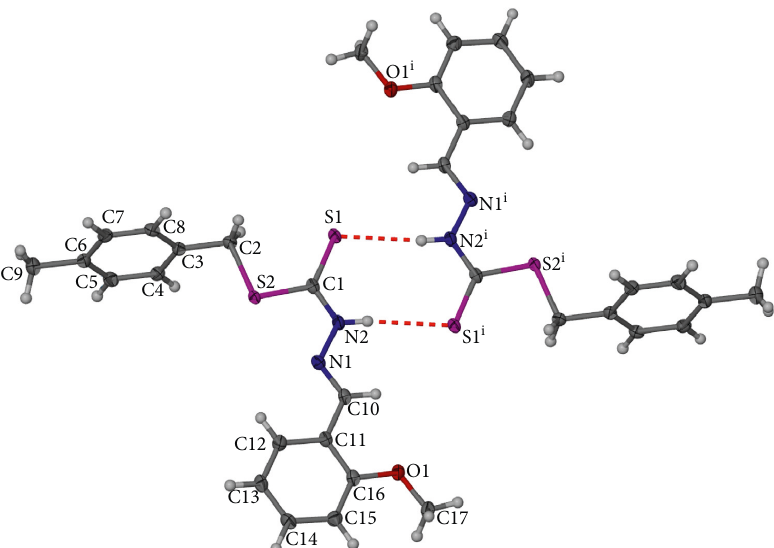
Figure 3: Structure of 1 . Symmetry elements used: (a) i � − x , 2 − y , − z, and (b) i � 2 − x , 1 − y , 2 − z .